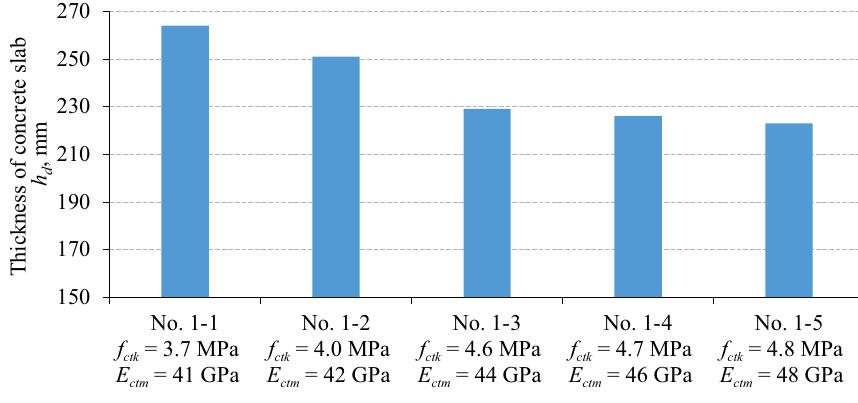
Figure 7. The effect of concrete mechanical properties on slab